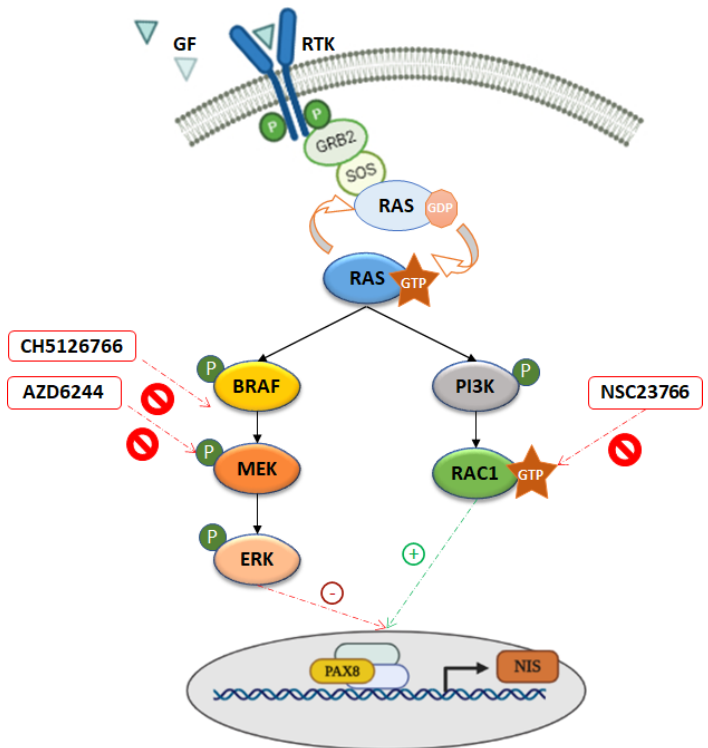
Figure 7. Working model for the opposite effects of MAPK and RAC1 signaling on NIS expression in thyroid cancer cells. Both NRAS- and BRAF-mutants are negative regulators of NIS expression and function; treatment with MEK1/2 inhibitor has a more meaningful positive impact in NRAS Q61R- than in BRAF V600E-expressing cells; NRAS, but not BRAF, stimulates RAC1 activity, which in turn, has a positive impact on NIS functional expression. The concerted action of MAPK pathway inhibition (which releases the repression of NIS transcription) and an increased RAC1 activity (which potentiates NIS expression and its plasma membrane abundance) could explain the better response to selumetinib treatment of thyroid tumors harboring NRAS-activating mutations over those carrying BRAF mutation (where NIS transcription is only partially rescued).